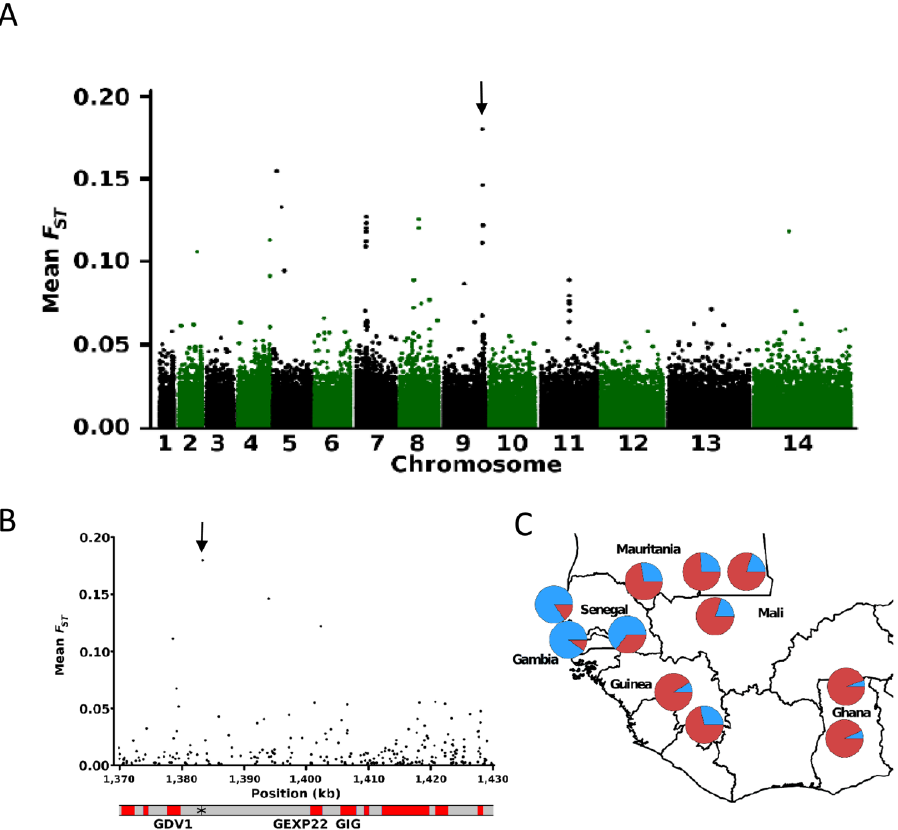
Figure 4. Scan for allele frequency divergence among 11 populations sampled across West Africa. ( A ) Mean F ST scores for all pairwise site by site comparisons plotted for each SNP across the genome (the overall genome wide mean F ST was 0.007). The arrow shows the locus with highest mean F ST value ( F ST = 0.18 for an intergenic SNP at position 1,383,344 of chromosome 9 adjacent to the gdv1 gene PF3D7_09035400). Table 2 lists this and three other genomic regions that each contained at least three SNPs with mean F ST > 0.05 and at least one SNP with mean F ST > 0.1 (with < 15 kb between adjacent SNPs having these high values). ( B ) Zoomed in view of F ST values of the SNPs in the most highly differentiated region on chromosome 9, with the highest F ST SNPs spanning the region between gdv1 and gexp22 . ( C ) Geographical allele frequency distribution of chromosome 9 SNP at position 1383344, with pie charts showing the reference 3D7-type allele (red), and the alternate allele (blue). Allele frequency distributions for the highest F ST SNP in each of the other three high F ST windows are shown in Supplementary Fig.